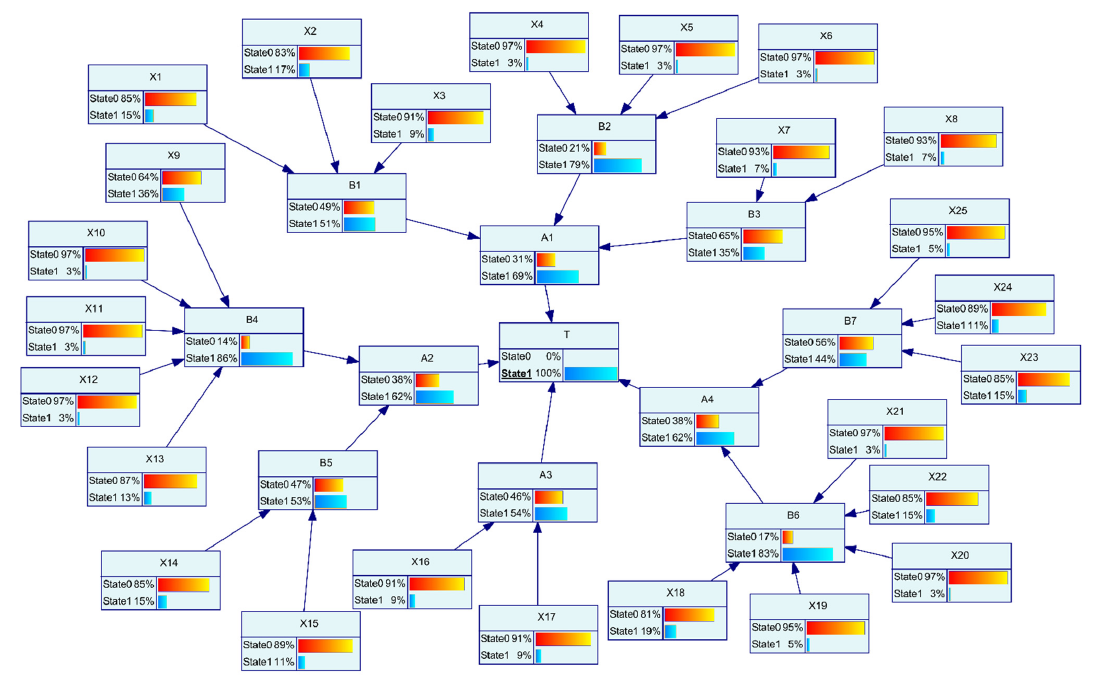
Figure 5. Posterior probabilities for causative factors contributing to BFG leakage accidents.